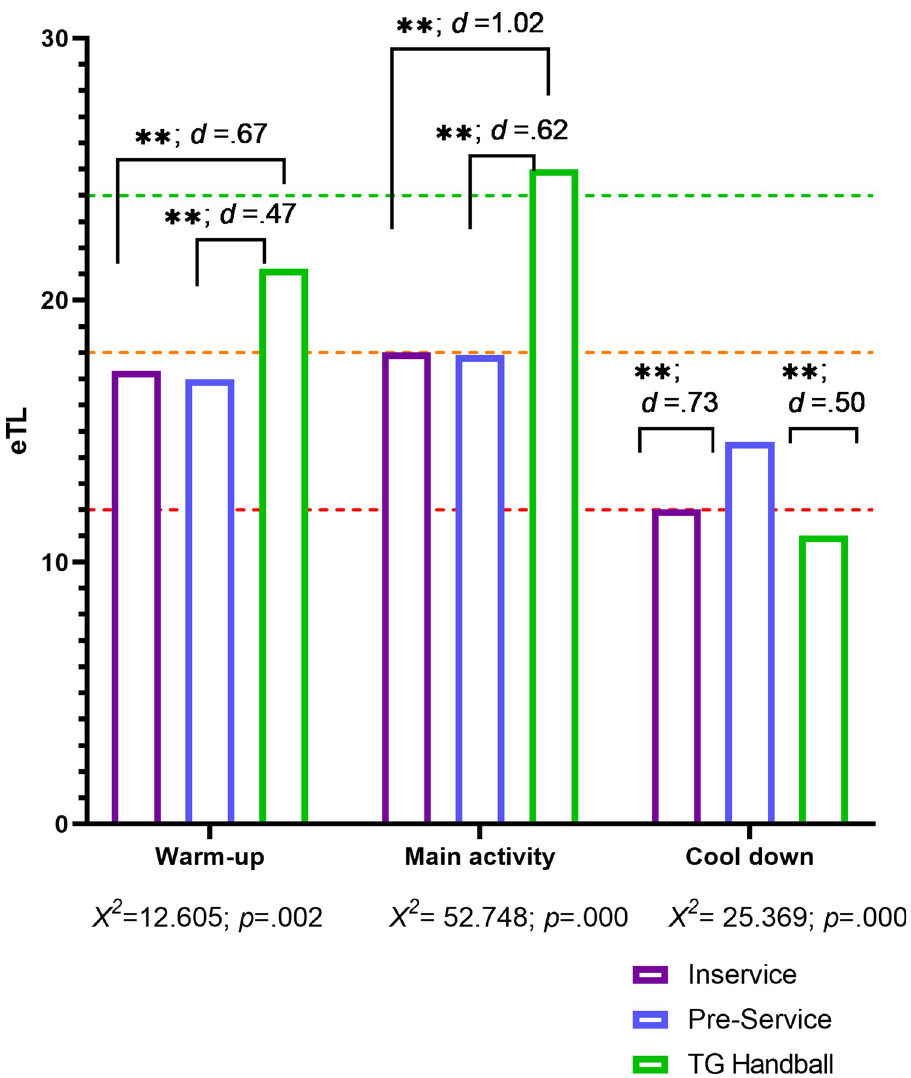
Fig 3. Differences in eTL according to the type of teacher in the different parts of the session ( �� p <